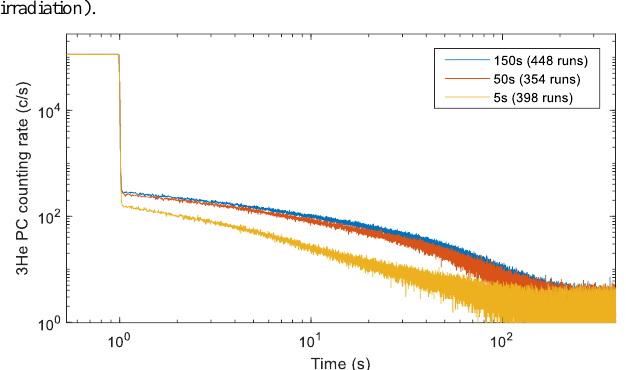
Fig. 8. Neutron emission of the 239 Pu target in three irradiation scenarios (5 s, 50 s and 150 s of irradiation). No dead time correction was taken into